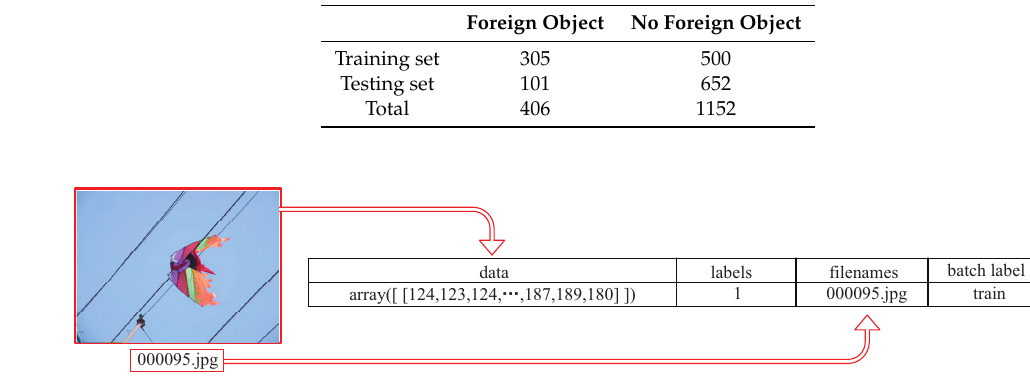
Figure 6. Cifar-10 data storage rules. The data stored in the [ 32 × 32 × 3 ] matrix are the compressed data of the original image. Labels store image tags, image with foreign objects is 1, and image without foreign objects is 0. File names are stored in filenames. The batch label stores the image as being divided into training or test